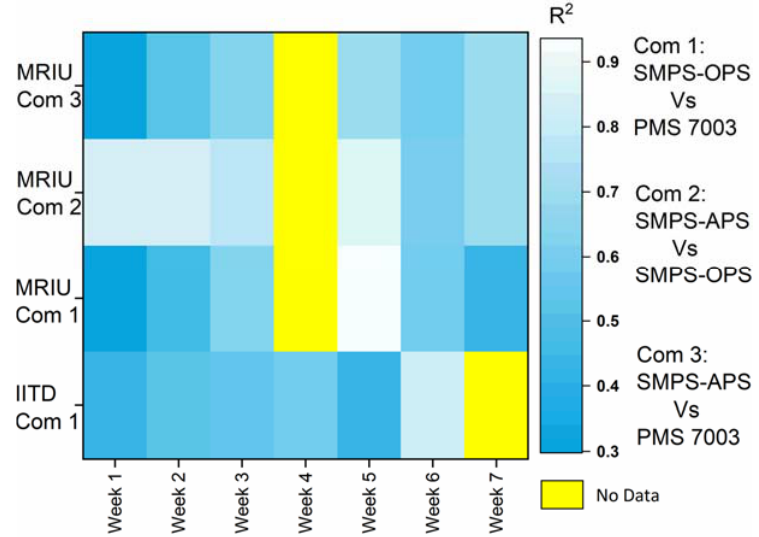
Figure 6. Heat map representing the coefficient of determinations ( R 2 ) for weekly basis data between the different studied instruments during their field deployment of seven weeks. The different shades of blue color represent different R 2 values ranging from 0.3–0.9, and the yellow color describes that there was no data collected during the specific week.